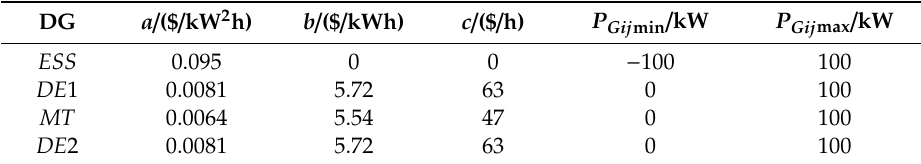
Table 9. Characteristic parameters of DG.